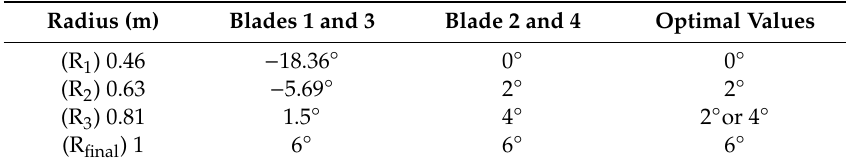
Table 2. Generated pitch angle values resulting from the blades following the straight trajectories with no change in their angular